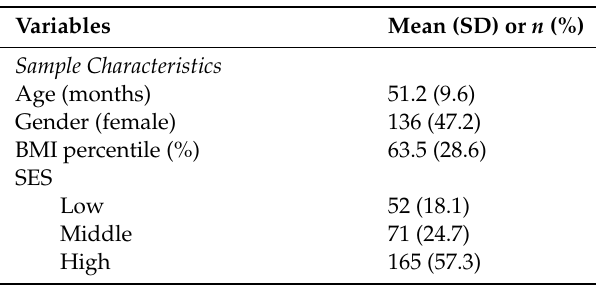
Table 1. Descriptive characteristics of the study